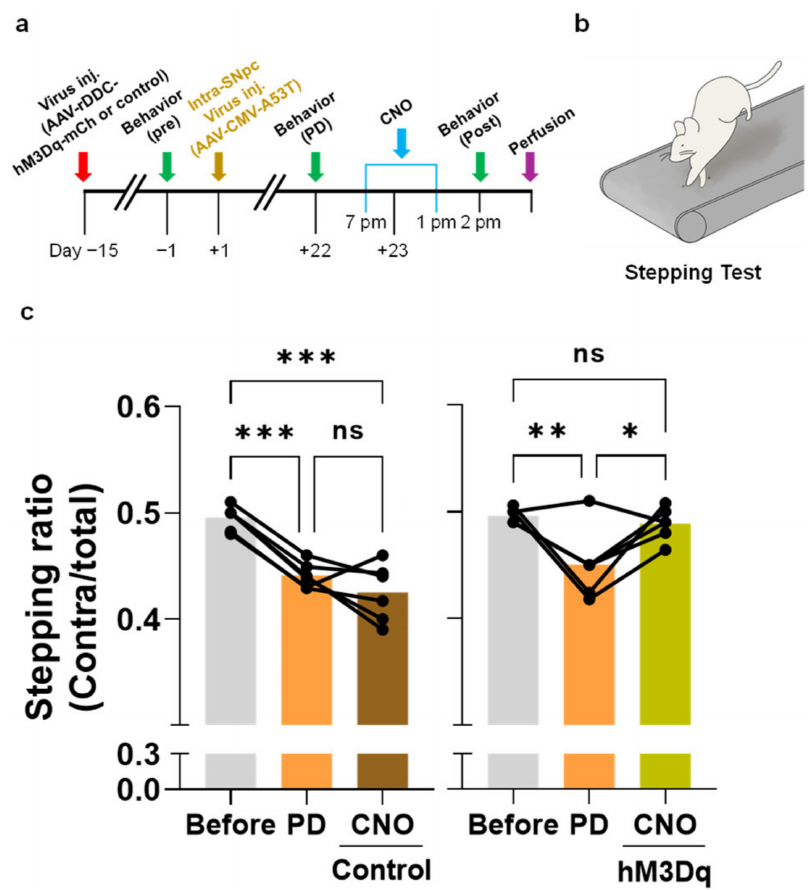
Figure 3. Chemogenetic activation of DDC neurons recovers PD-like motor symptoms of the A53T rat PD model in the stepping test. ( a ) Timeline of the experimental procedures; ( b ) schematic figure of stepping test; ( c ) quantification of stepping ratio (contralateral step number/total step number) before AAV-A53T virus injection (pre), 3 weeks after AAV-A53T virus injection (PD), and after intraperitoneal CNO (1.5 mg/kg) administration (post) (Control, n = 6 rats; hM3Dq, n = 6 rats). The data normality was assessed by Shapiro–Wilk normality test. Statistical significance was calculated by repeated-measure one-way analysis of variance (ANOVA) with Tukey’s multiple comparison test. The significance levels are represented as asterisks (* p < 0.05, ** p < 0.01, *** p < 0.001; ns, not